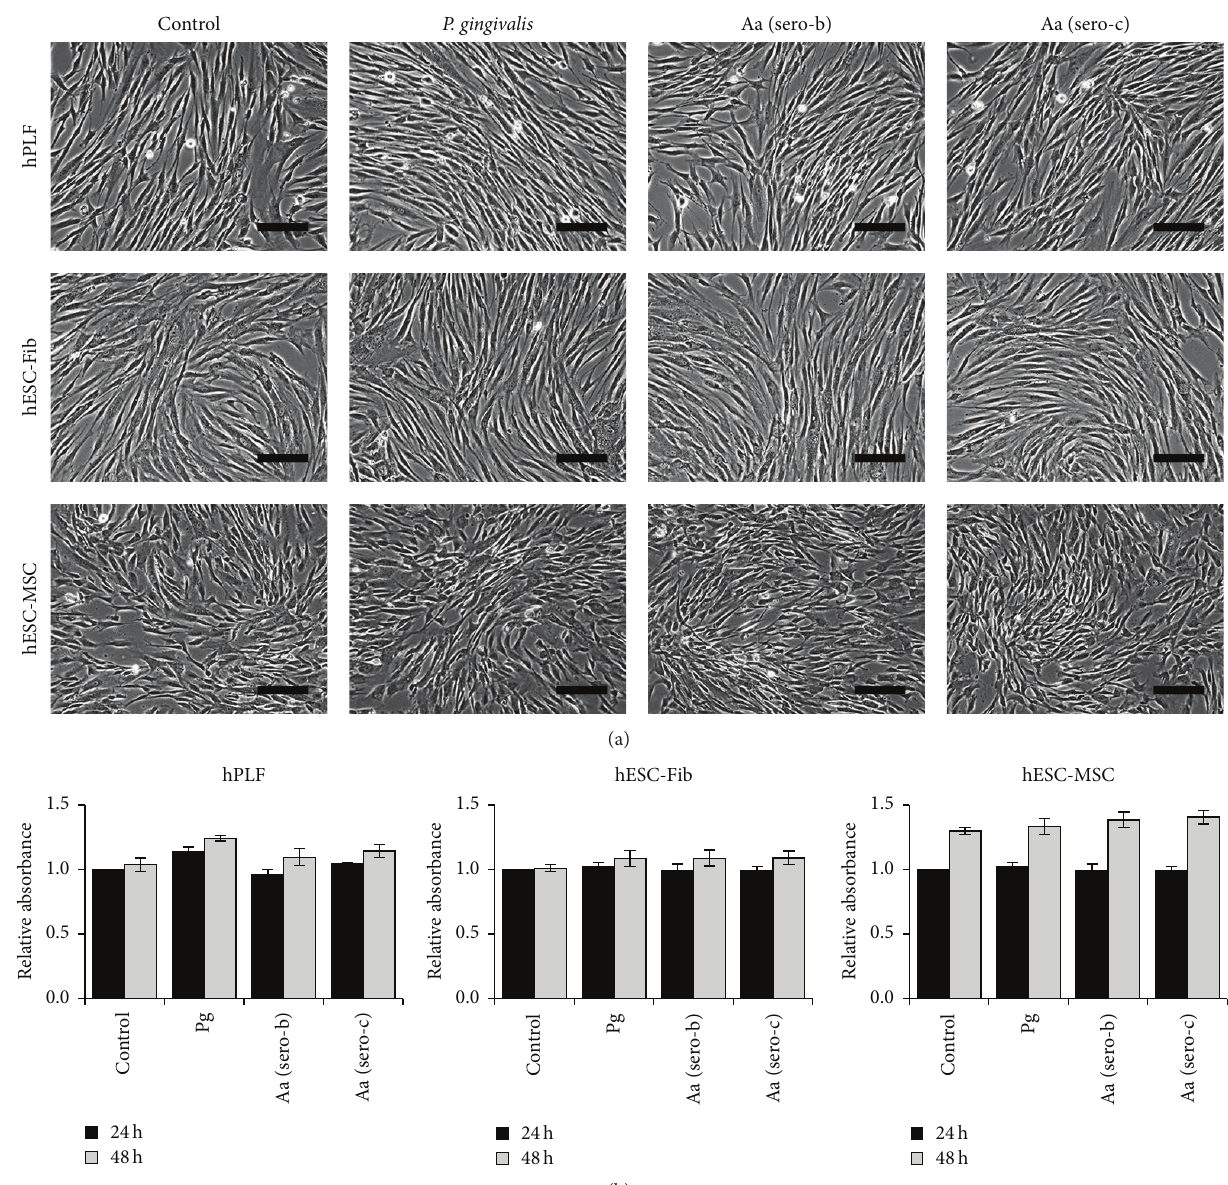
Figure 3: Viability and proliferation of hPLFs, hESC-Fib, and hESC-MSCs. (a) Morphology of control and treated groups after 48 hours of bacterial challenge. (b) Viability and proliferation of cells assessed by MTS assay after exposure to P. gingivalis (Pg) and two different serotypes of A. actinomycetemcomitans (Aa serotypes b and c) for 24 and 48 hours. Scale bar: 200 𝜇